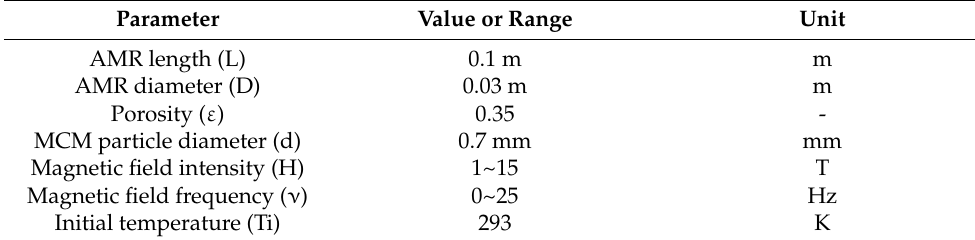
Table 1. AMR sizes and operating parameters of simulation.